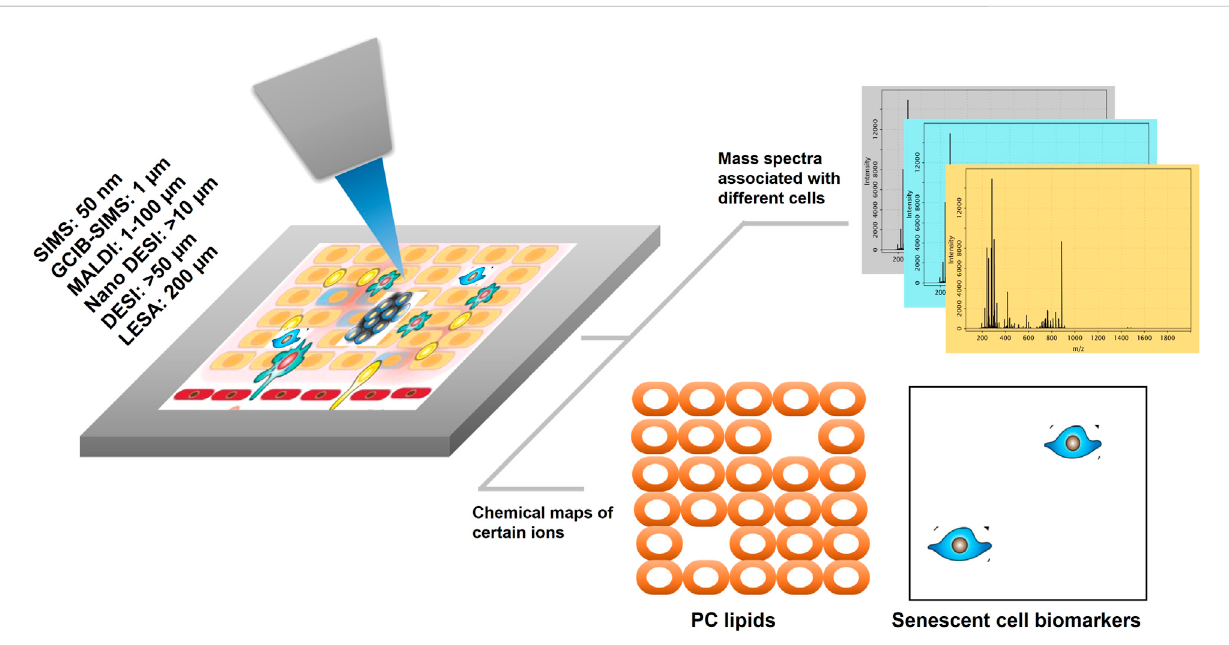
FIGURE 1 A simpli fi ed work fl ow of MSI for spatial omics. The focused ion desorption source scans the tissue surface (or cells in culture) pixel by pixel. Both mass spectra and x and y coordinates are generated from each pixel. With the single-cell resolution of the ion desorption source, omics information is obtained from individual cells in the tissue or cell culture without tissue dissociation. Biomolecules or biomarkers are localized to cellular structures or different cell populations. Technical approaches for MSI work fl ows include: SIMS, secondary ion mass spectrometry; GCIB, gas cluster ion beam; MALDI, matrix-assisted laser desorption ionization; DESI, desorption electrospray ionization; LESA, liquid extraction surface